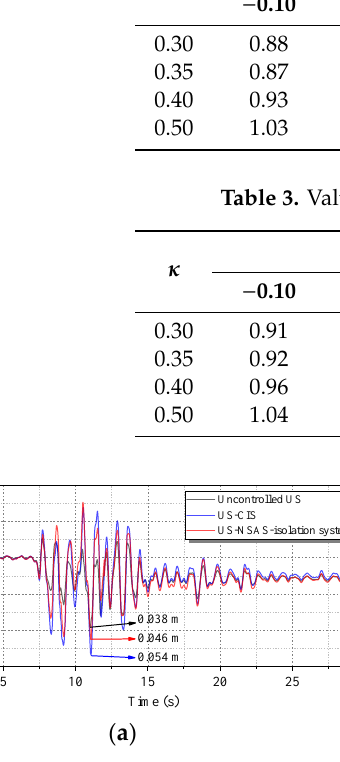
Figure 12. Time series of relative displacements of central column for uncontrolled underground structure (US), controlled by conventional isolation system (US-CIS) and controlled by negative stiffness amplification system (US-NSAS)-based isolation system. ( a ) Port Island and ( b ) HIK station records. Table 2. Values of